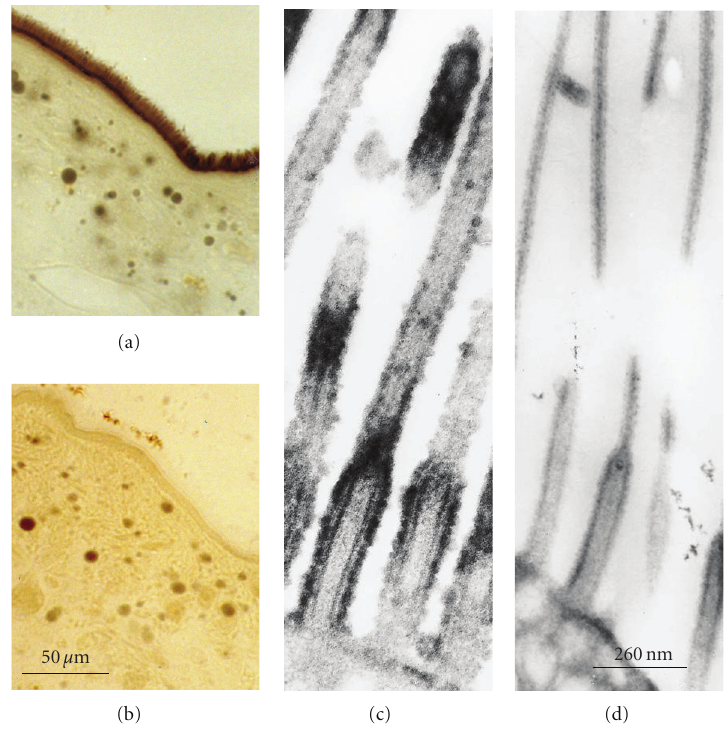
Figure 5: Light and electron micrographs of sections of the bladder wall of cysticerci incubated for 1 hour with PBS ((a) and (c)) and PLC ((b) and (d)) and probed with